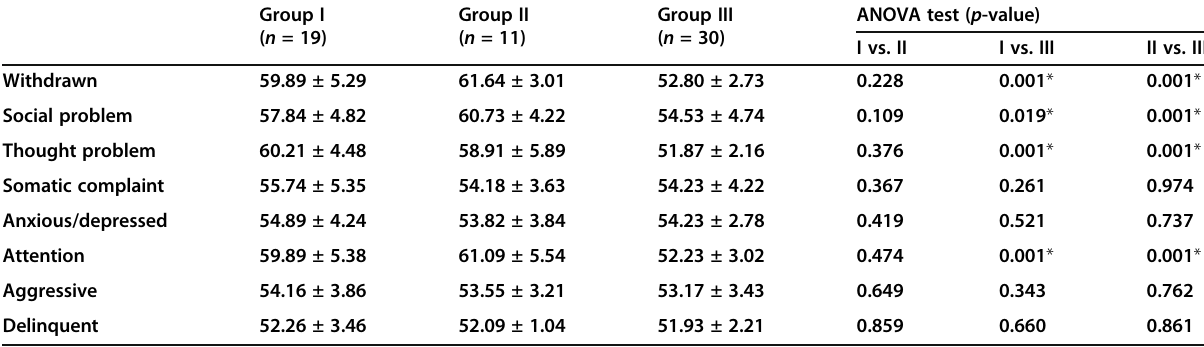
Table 1 Comparison between studied groups in child behavior